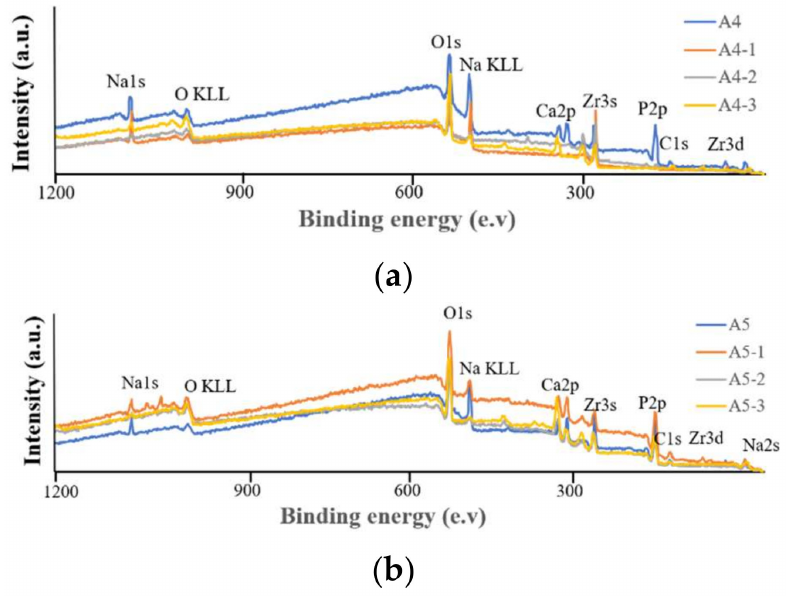
Figure 7. ( a ) XPS analysis of calcium hydroxide soaking, with A4 as the base. ( b ) XPS analysis of calcium hydroxide soaking, with A5 as the